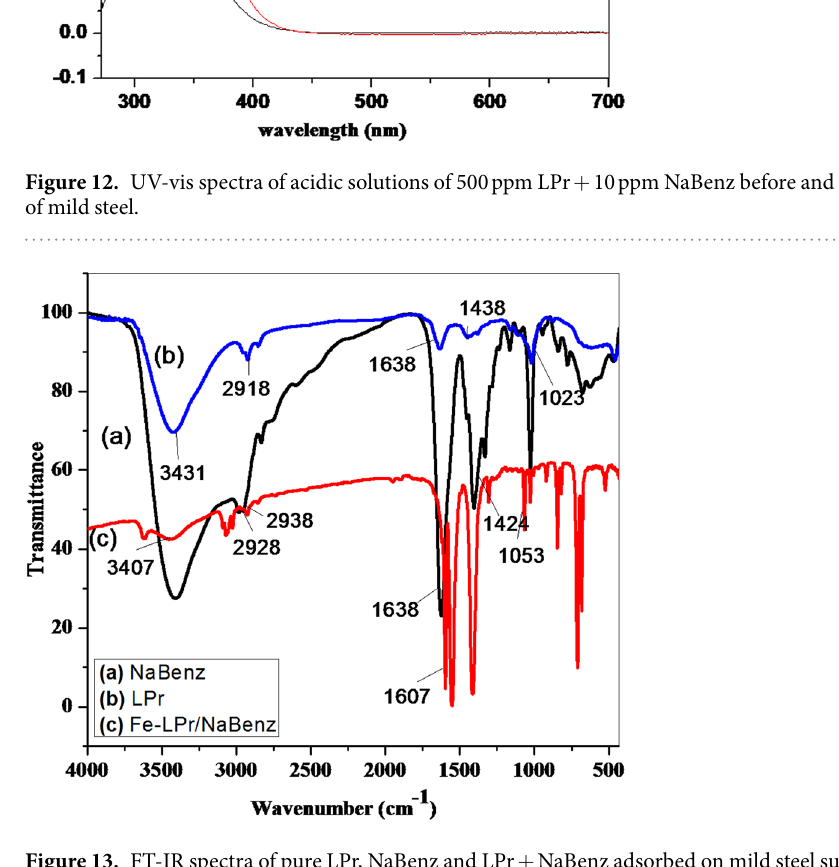
Figure 13. FT-IR spectra of pure LPr, NaBenz and LPr + NaBenz adsorbed on mild steel surface after 6 h